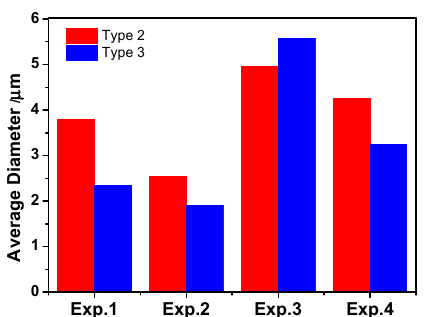
Figure 7. Three-dimensional average diameter of Type-2 and 3 inclusion.